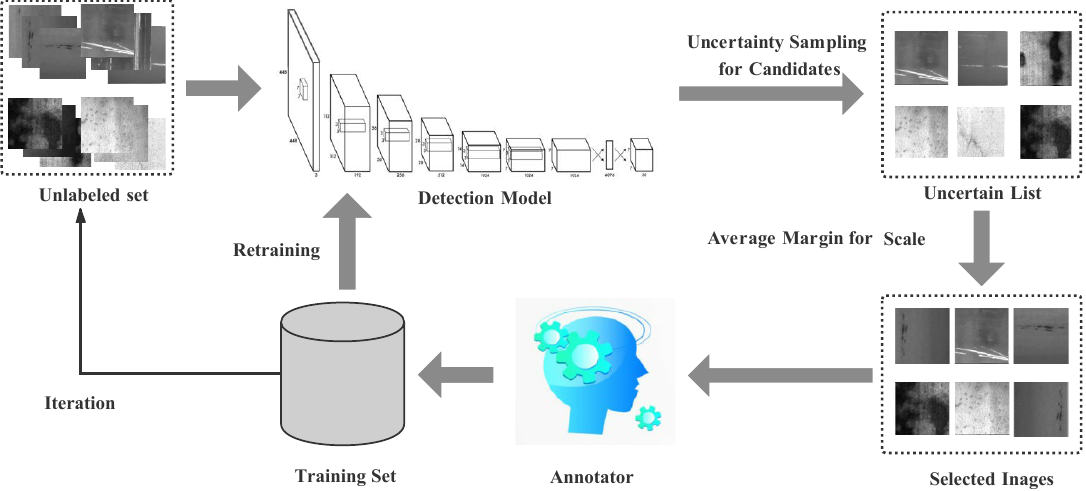
Figure 1. Overview of the proposed active learning framework. First, a defect detection model (neural network) is initialized via pre-training weights. Second, unlabeled images are fed into the detection model for prediction results. Then, combined with the proposed strategies, uncertain images are selected for querying annotations. After being labeled by annotators, the images can be added into the training set, and the detection model is updated from scratch. The above steps are repeated until the required performance is achieved.